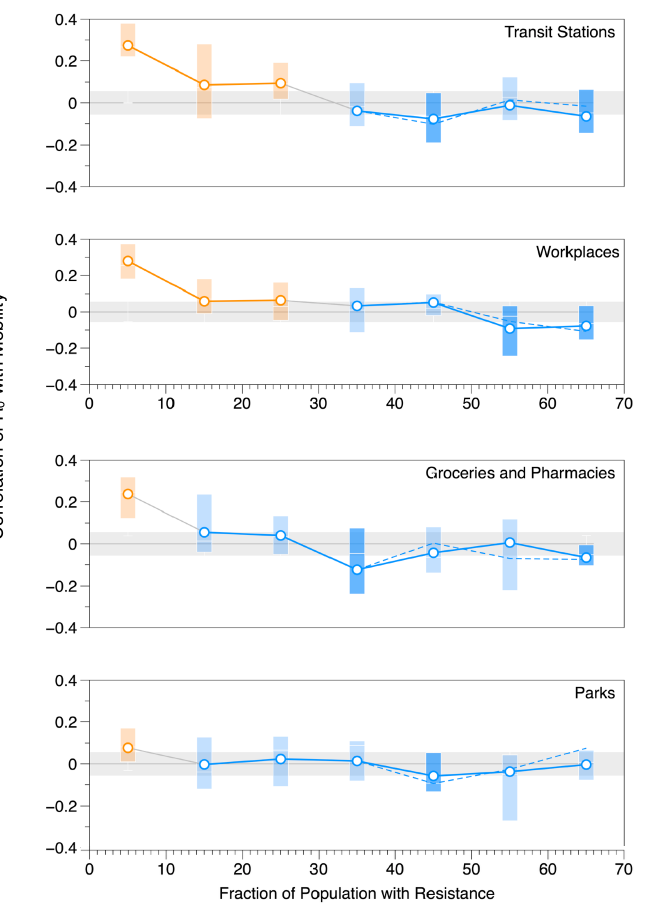
Figure 8. Correlation between COVID-19 transmission rates and mobility in transit stations, work- places, groceries and pharmacies, and parks as a function of the fraction of the population with resistance, FR. The solid line only includes pre-Delta variants; the dashed line represents all variants, including Delta. Points in which there is a clear correlation are orange; points where the correlation is indistinguishable from zero (suggesting that mobility-restricting measures are no longer effective) are blue; grey regions indicate +/ − the standard error in the